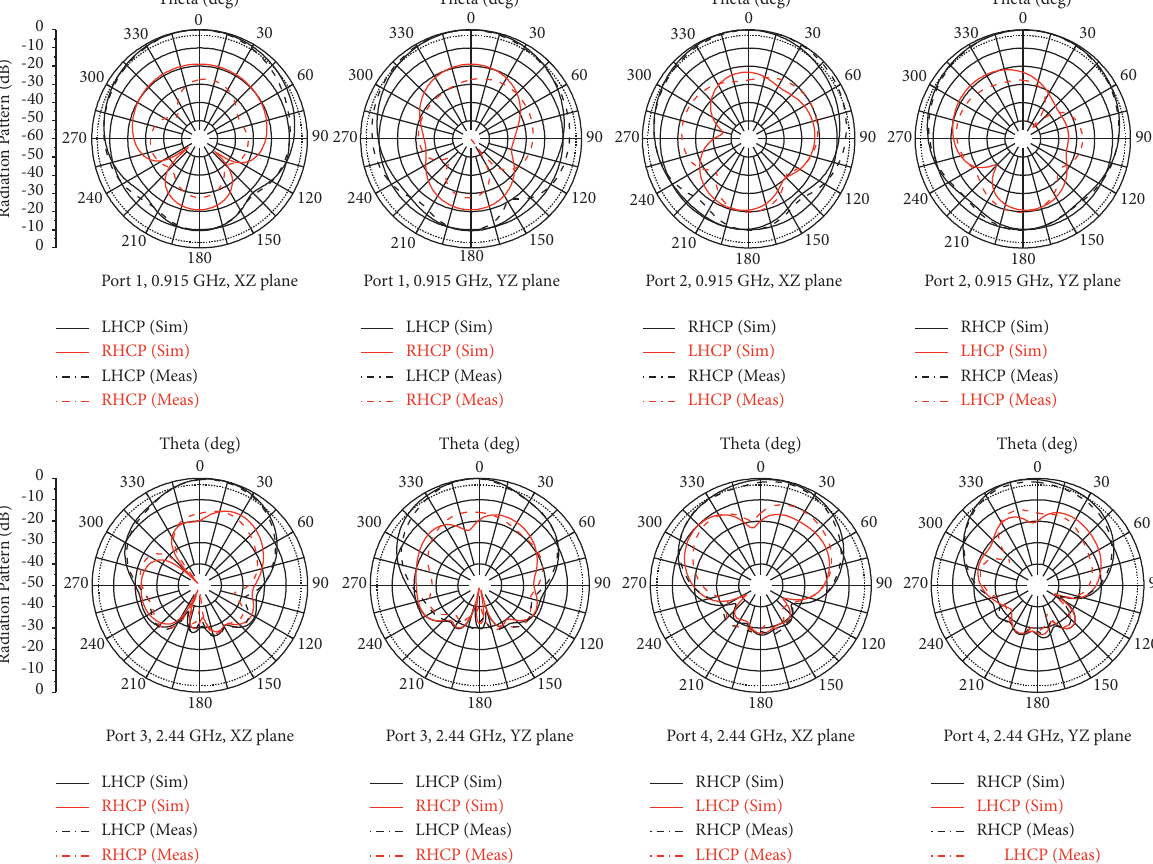
Figure 10: Simulated and measured normalized radiation patterns at Ports 1 and 2 (0.915GHz) and Ports 3 and 4 (2.44 GHz) in XZ and YZ